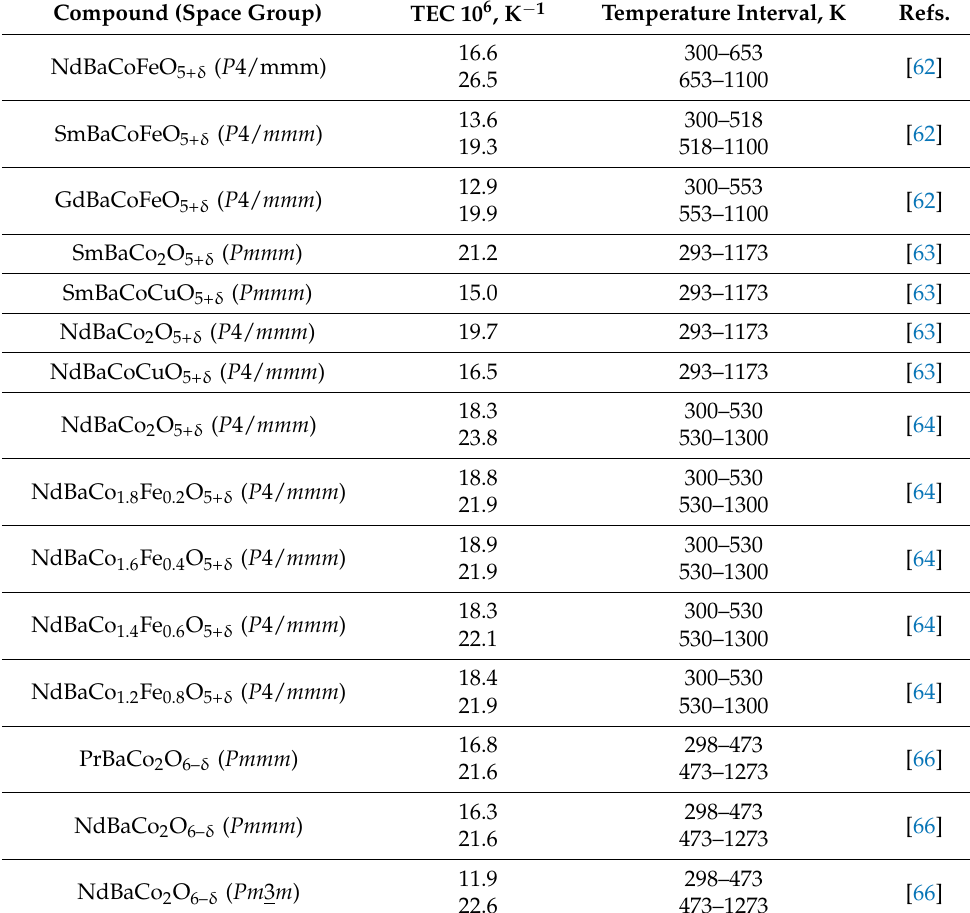
Table 1. TEC values of some layered oxygen-deficient perovskites. Compound (Space Group) TEC 10 6 , K − 1 Temperature Interval, K Refs. NdBaCoFeO 5+ δ ( P